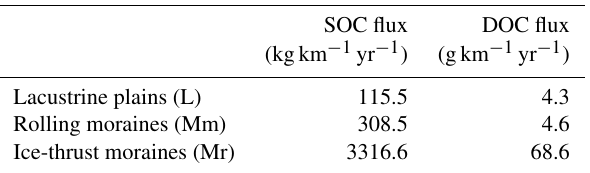
Table 3. Total SOC and DOC flux mobilized between 1972 and 2011 by RTSs initiated after 1972, per year and kilometer for each geologic